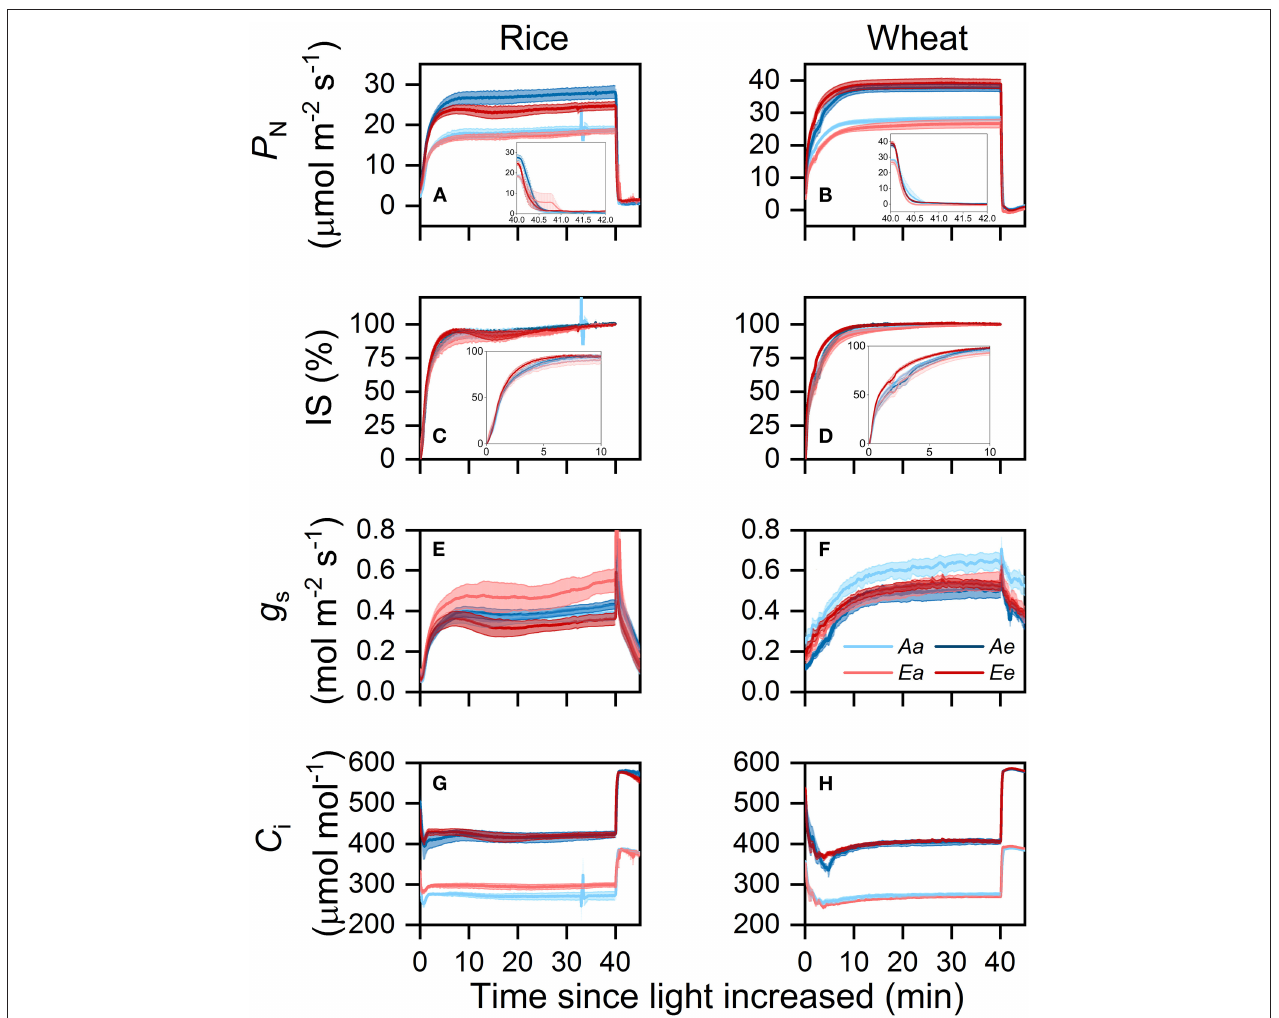
FIGURE 2 | Time courses of P N (A,B) , IS (C,D) , g s (E,F) , and C i (G,H) in rice (A,C,E,G) and wheat (B,D,F,H) leaves following an increase in light intensity from 100 to 1,500 µ mol photons m − 2 s − 1 and then a decrease in light intensity from 1,500 to 50 µ mol photons m − 2 s − 1 . Values are presented as the means ± SE of three to four biological replicates, i.e., individual plants for each species. P N , photosynthetic rate; IS, induction state; g s , stomatal conductance; C i , intercellular CO 2